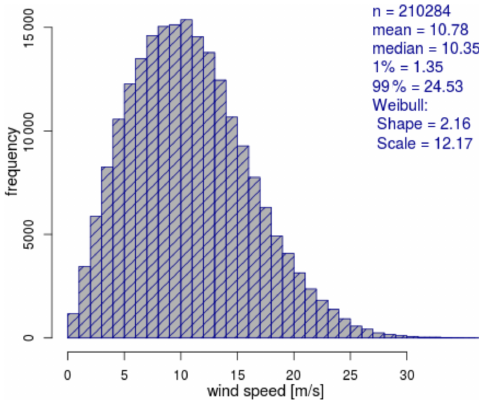
Figure A1. Wind speed histogram with total number of samples ( n ), mean wind speed, median wind speed, 1% and 99% percentiles, and Weibull shape and scale parameters.